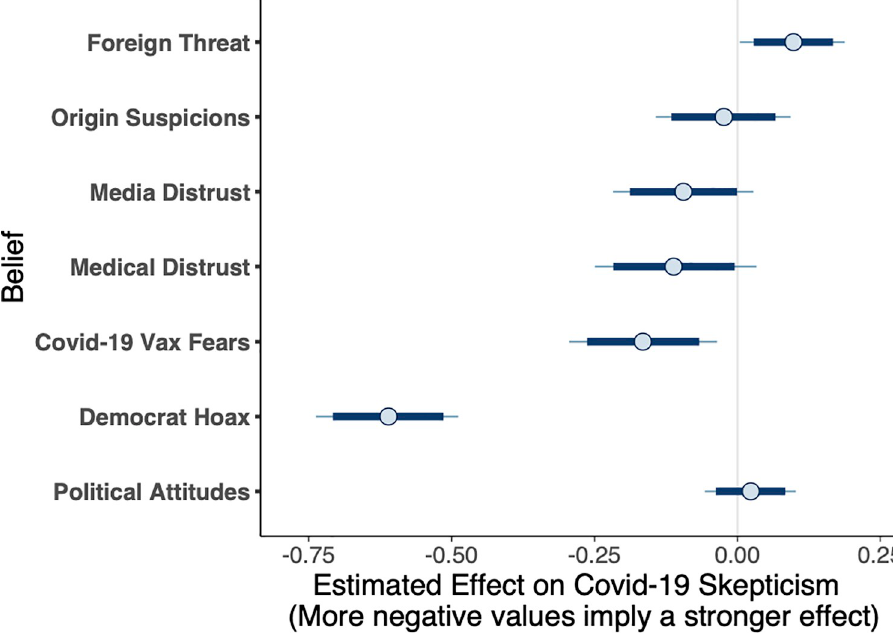
Fig 2. Posterior regression estimates for predictors of prewave COVID-19 attitudes. Circle = mean, thick bar = interior 95%, thin bar = interior 99% of posterior distribution.